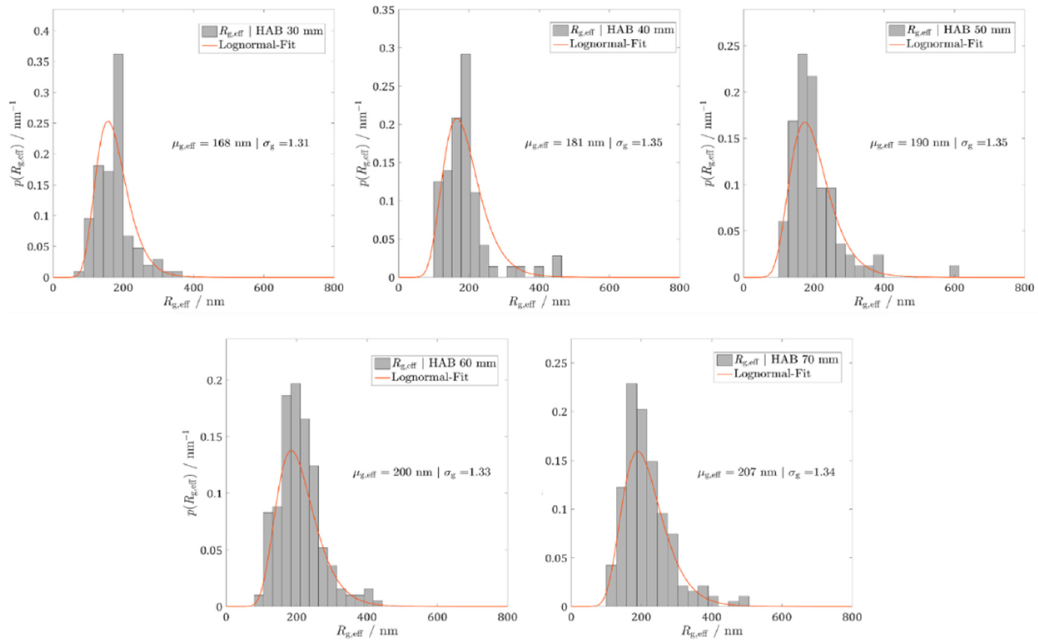
Figure 14. Distribution of the effective R g,eff at 30, 40, 50, 60, and 70 mm HAB for the baseline diesel CEC RF-79-07.